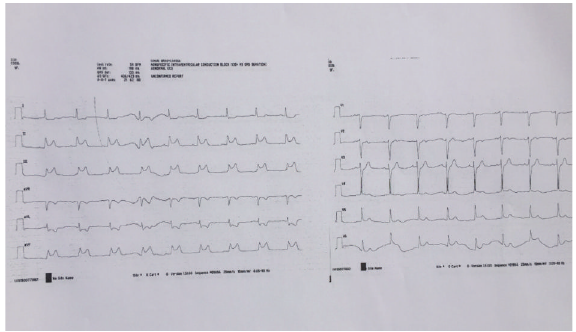
Figure 1: ST segment elevation on inferior electrocardiographic leads.